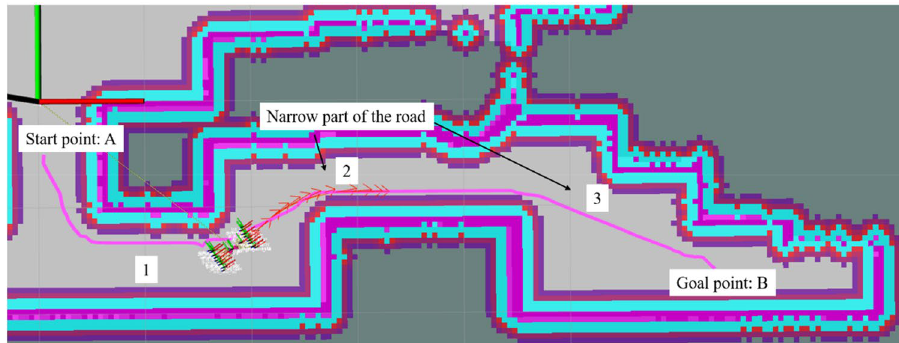
Figure 12. The robot passes through the narrow road.